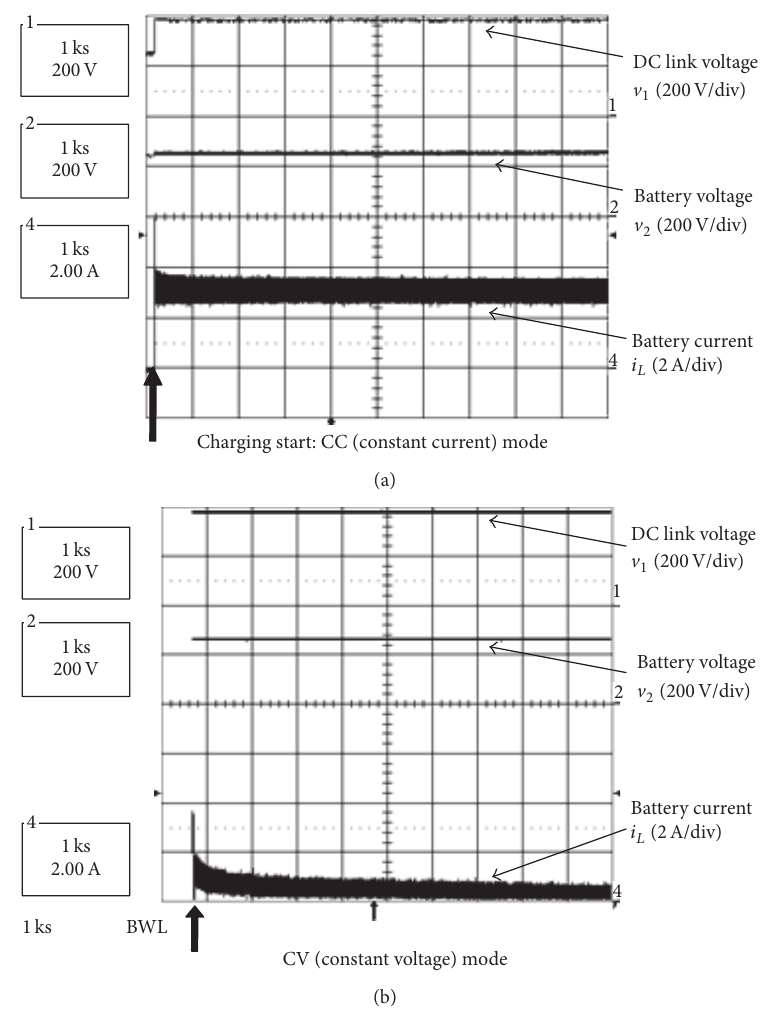
Figure 6: Experimental result for battery charging performance. (a) CC mode; (b) CV mode.